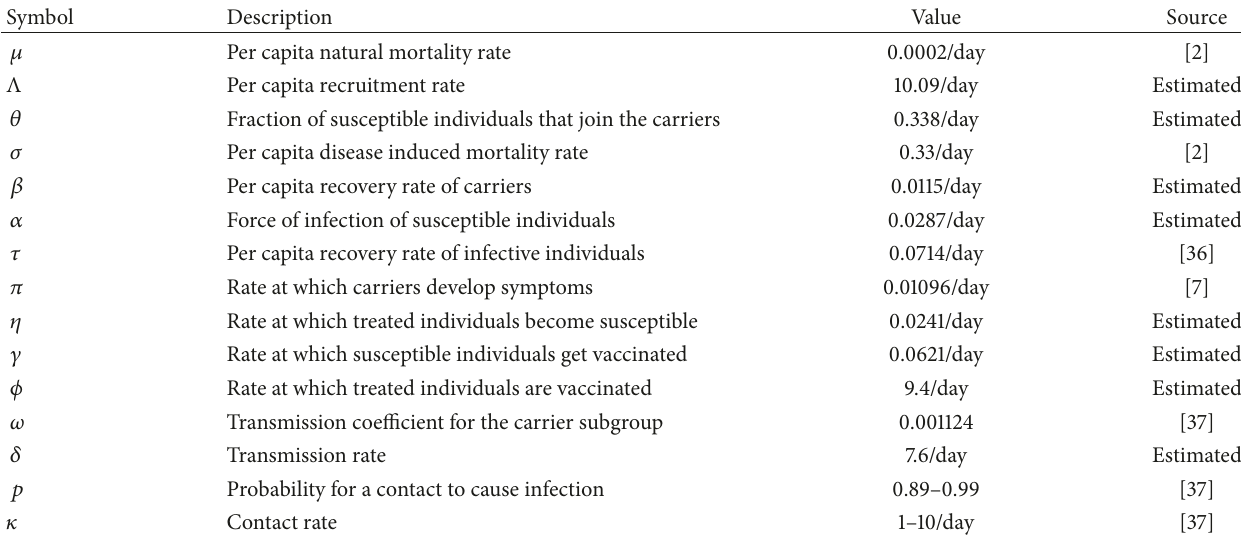
Table 2: Parameter estimates for pneumonia model under interventions.